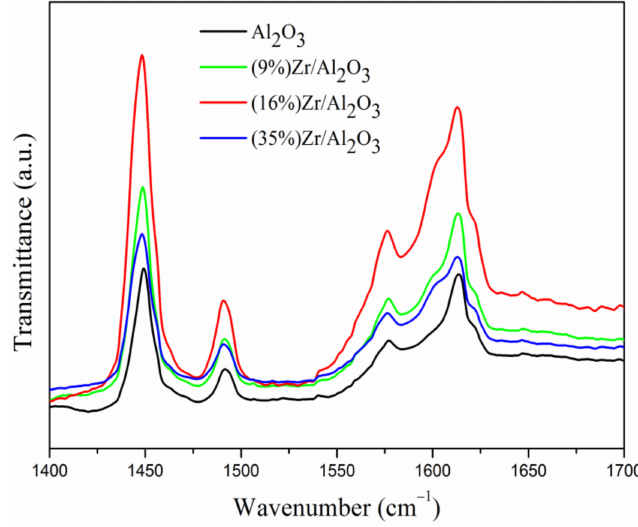
Figure 4. FT-IR spectra of pyridine adsorption on γ -Al 2 O 3 and Zr/ γ -Al 2 O 3 .